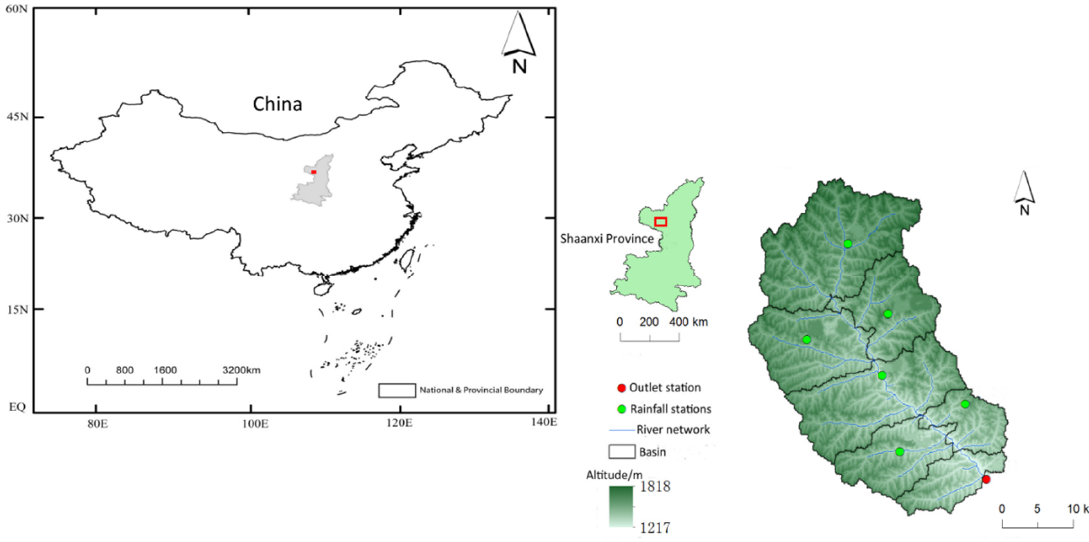
Figure 1. Map of China showing the location of the study area and the Zhidan watershed area showing the river network with the meteorological stations and the hydrometeorological station (outlet).